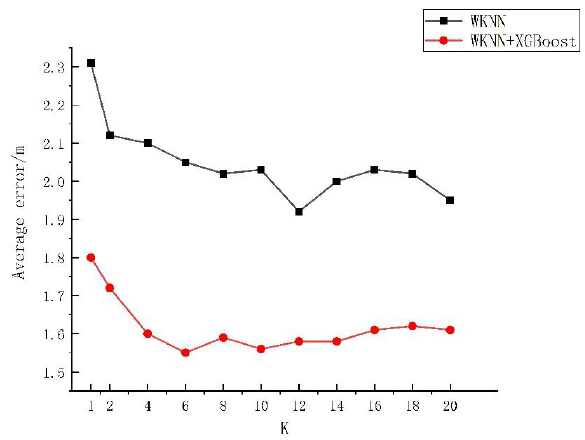
Figure 4. The influence of K value on error.